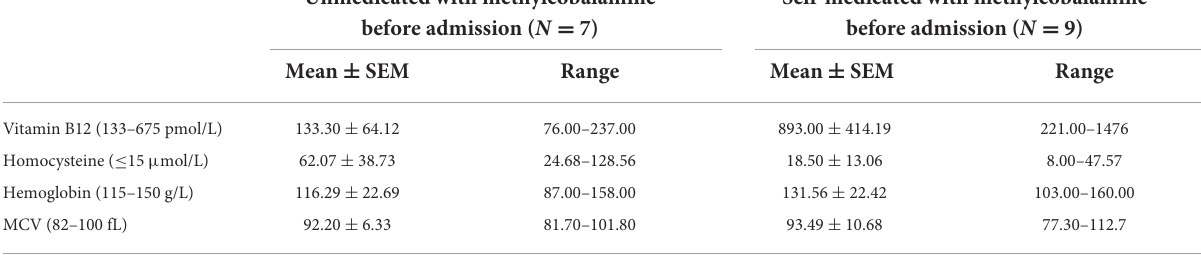
TABLE 2 Laboratory findings of N 2 O abuse resulting in neuropsychiatric disorders.